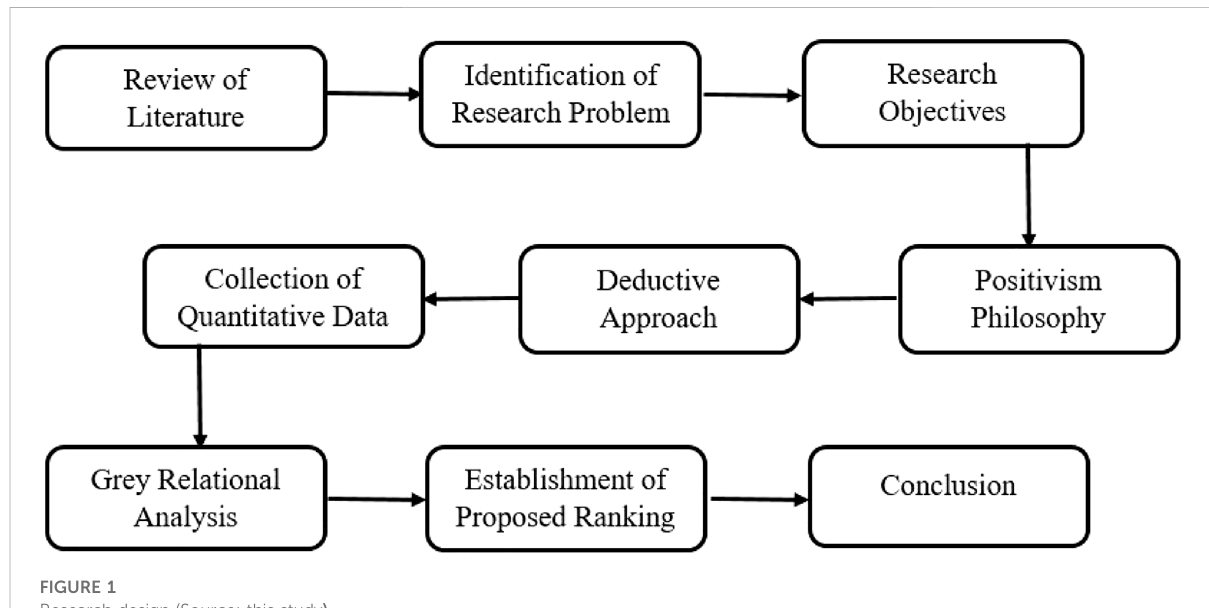
FIGURE 1 Research design (Source: this study